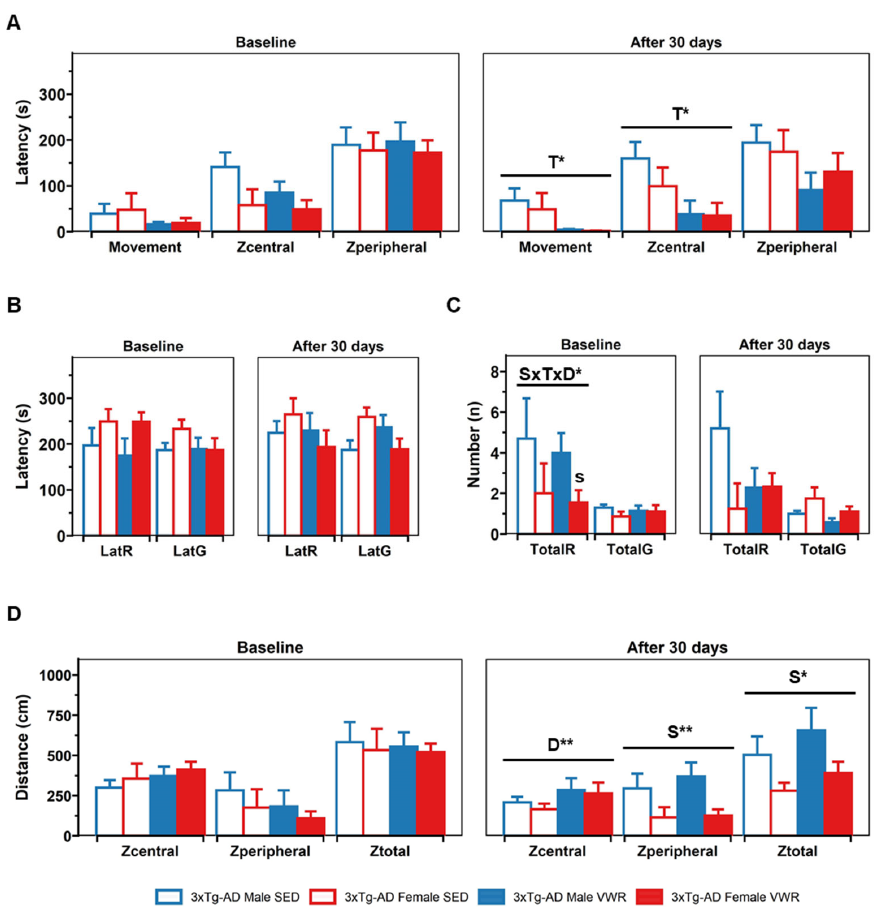
Figure 3. Open field test. ( A ) Horizontal activity latencies: movement latency (movement), latency to start exploring in the central zone (Zcentral), latency to reach the periphery (Zperiphery). ( B ) and ( C ). Vertical activity: rearing latency (LatR), grooming latency (LatG), total rearing episodes in 5 min (TotalR), total grooming episodes in 5 min (TotalG) ( D ) distance covered in the OF in the central zone (Zcentral), peripheral zone (Zperiphery), and total field (Ztotal). Factorial analysis: D, days;